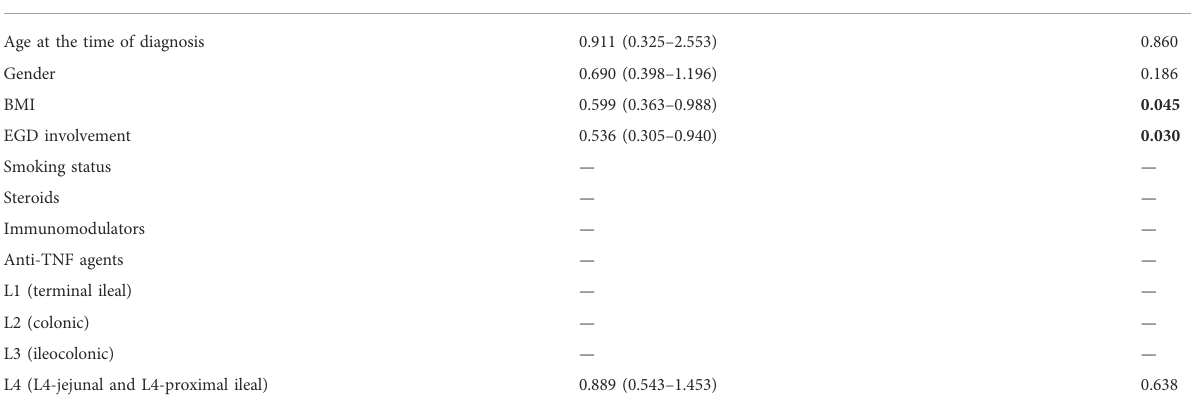
TABLE 3 Analysis of possible risk factors predicting abdominal surgery using the Cox Model ( N = 222).